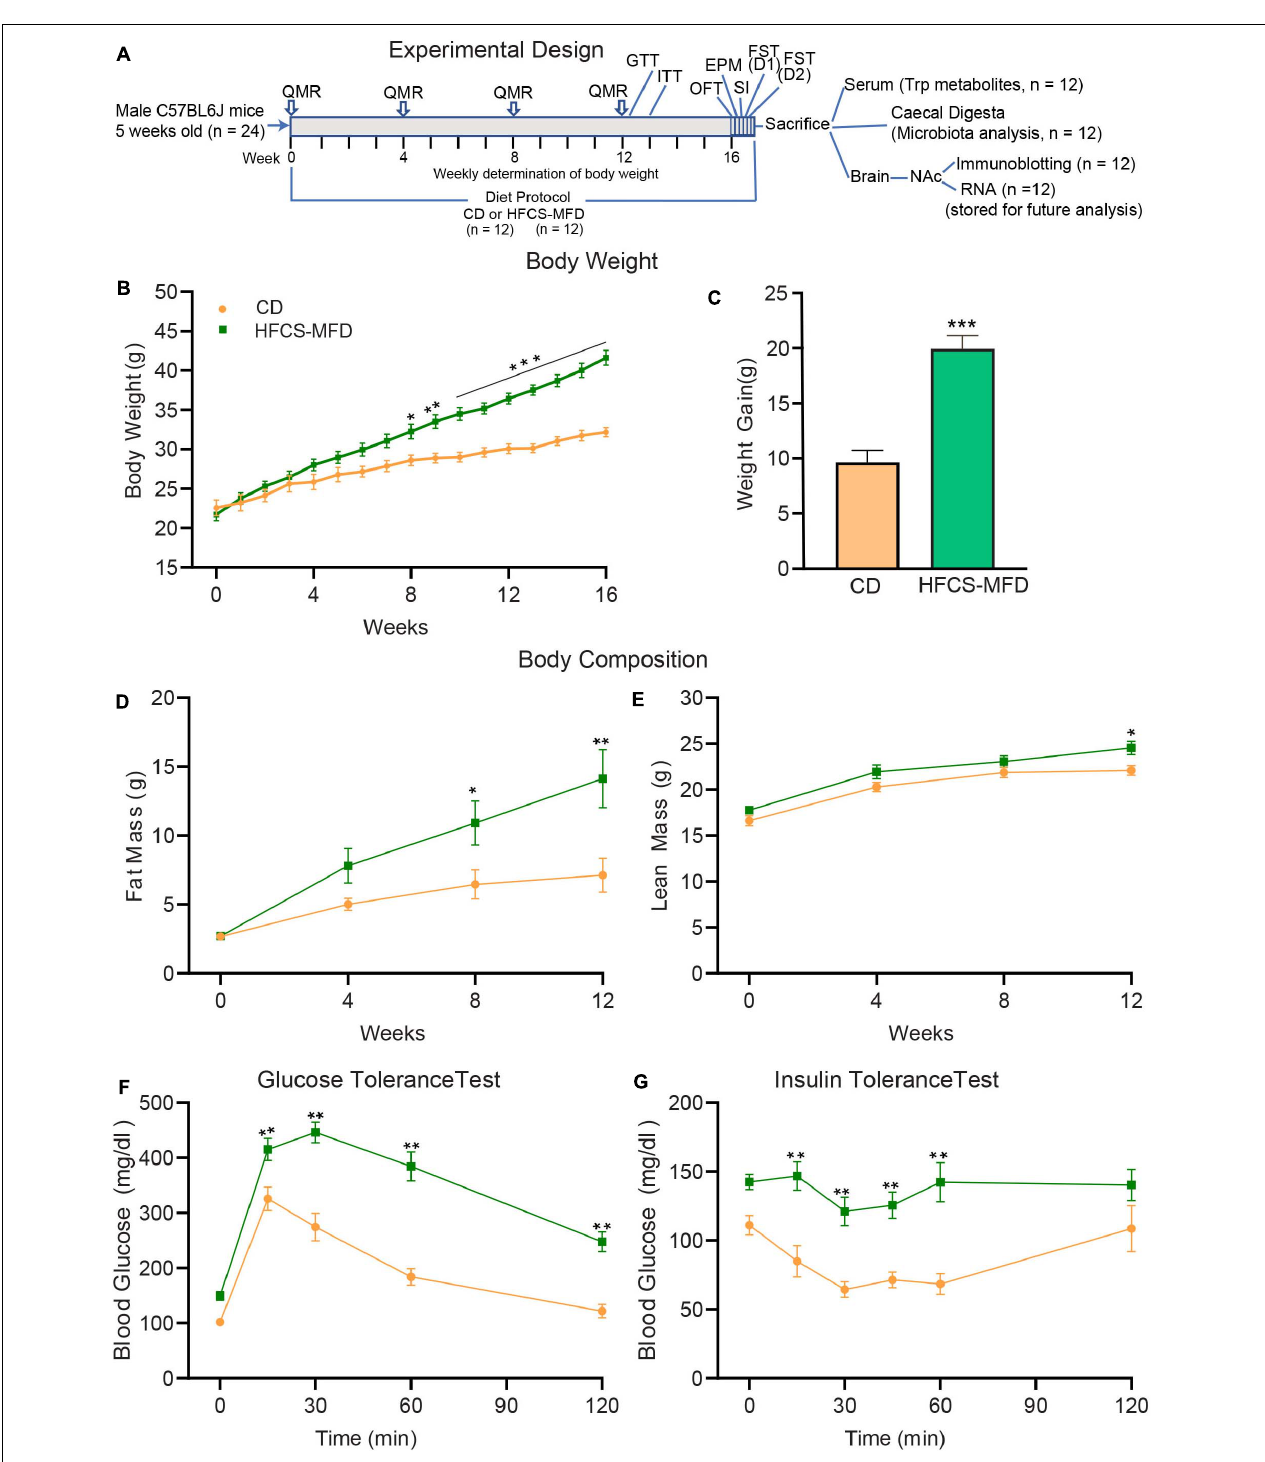
FIGURE 1 | HFCS-MFD consumption induces metabolic impairments. (A) Schematic overview of the experimental design. Body weight, body composition analysis by QMR and metabolic parameters including glucose tolerance (GTT) and insulin tolerance (ITT) were assessed during16 weeks of CD or HFCS-MFD consumption at time points indicated. After 16 weeks of diet administration, behavioral tests including OFT, EPM, SI, FST day 1 (D1) and day 2 (D2) were conducted before samples were derived for the analyses indicated. (B) Body weight of CD and HFCS-MFD fed mice for 16 weeks. (C) Average body weight gain over 16 weeks of dietary treatments. Quantitative magnetic resonance analysis of (D) body fat mass and (E) lean body mass in CD and HFCS-MFD mice (F) Glucose tolerance test and (G) Insulin tolerance test after 12 weeks of diet. All data are Means ± S.E.M., n = 9-12 per group; * p < 0.05, ** p < 0.01, *** p < 0.001 Repeated measures ANOVA with Bonferroni’s post hoc test, except for (C) which used unpaired t -test.